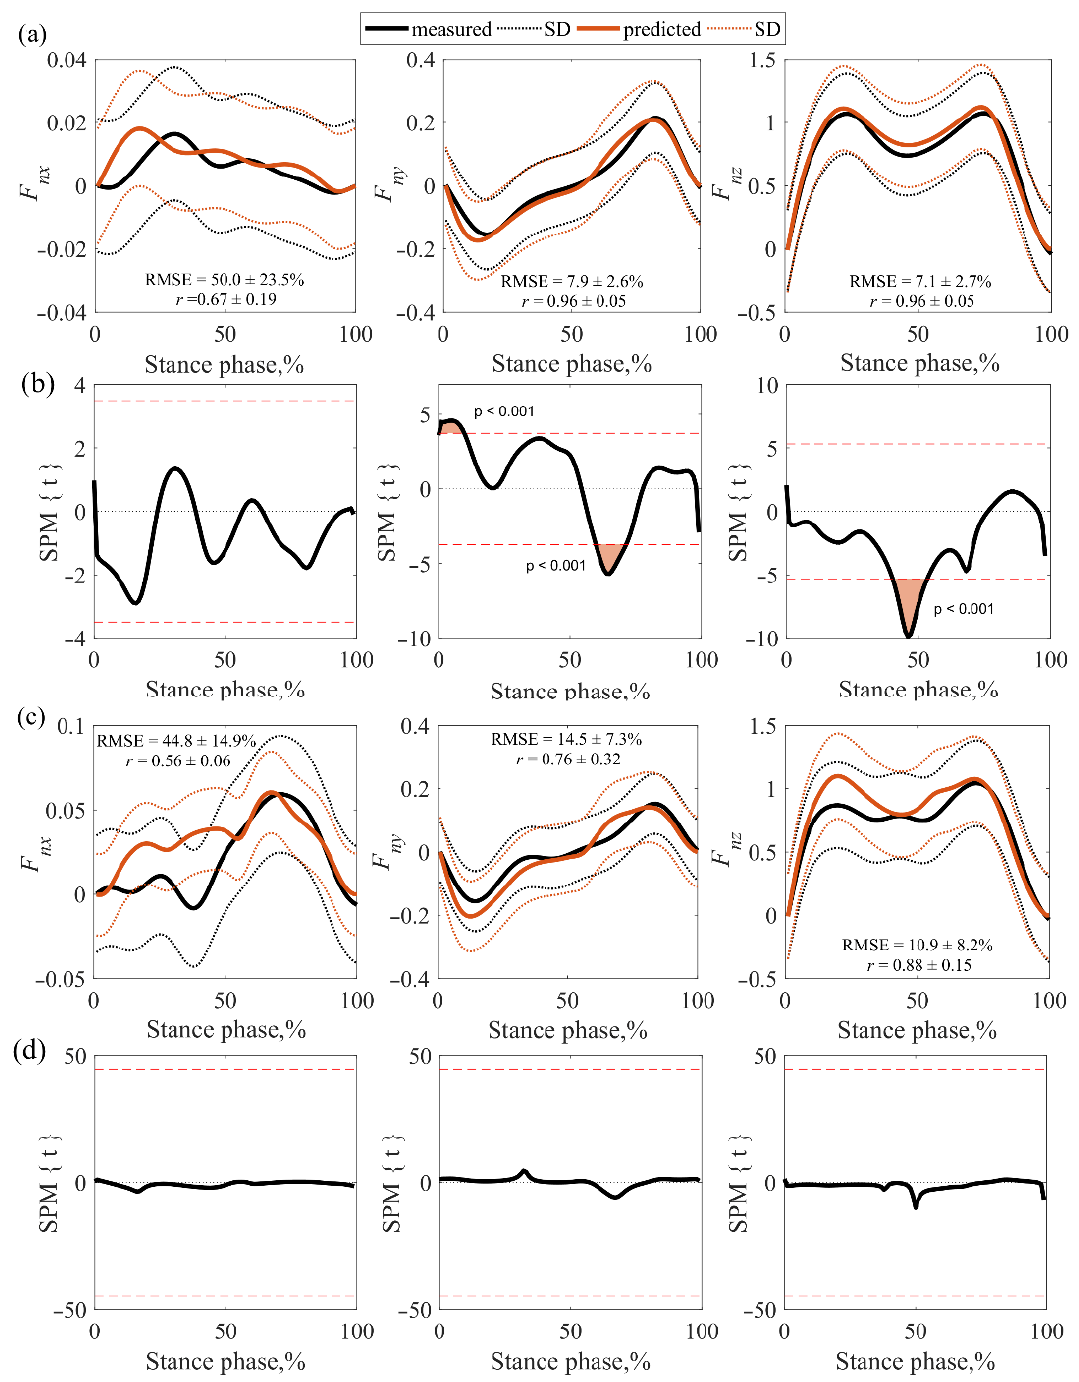
Figure 8. Results of the comparison of the measured and model predicted GRFs for the left leg: ( a ) averaged force curves for the HCH; ( b ) mismatch of HCH curves; ( c ) averaged force curves for the CP subjects; ( d ) mismatch of CP curves.